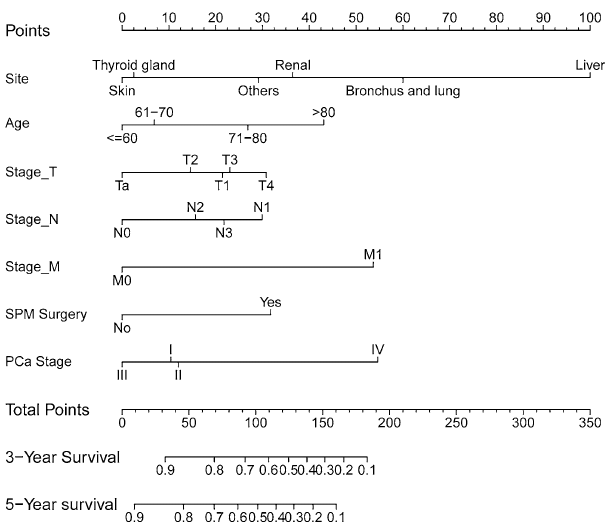
Figure 4. Nomogram to predict 3- and 5-year survival for second primary malignancy (SPM) patients.